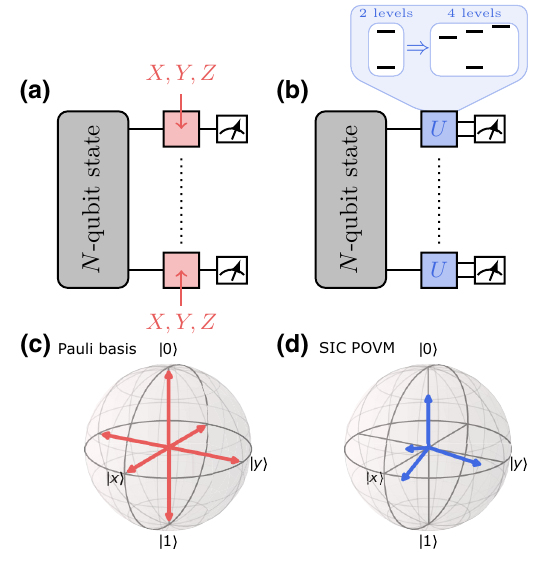
FIG. 1. Schematic illustration of Pauli and SIC tomography. Pauli tomography (a) uses three basis measurements per qubit to obtain tomographic information about an unknown N -qubit system; see (c). Each basis measurement is contingent on one of three possible unitary rotations—red boxes in (a). This pro- duces a total of 3 N different measurement settings that need to be accessed. SIC tomography (b), on the other hand, uses the same measurement setting for each qubit; see (d). This nonorthogonal measurement is achieved by isometrically embed- ding each two-level system (qubit) into a larger four-level system (ququart)—blue boxes in (b)—and subsequently measuring this larger system. The experimental realization of this embedding within each ion is shown in Fig.